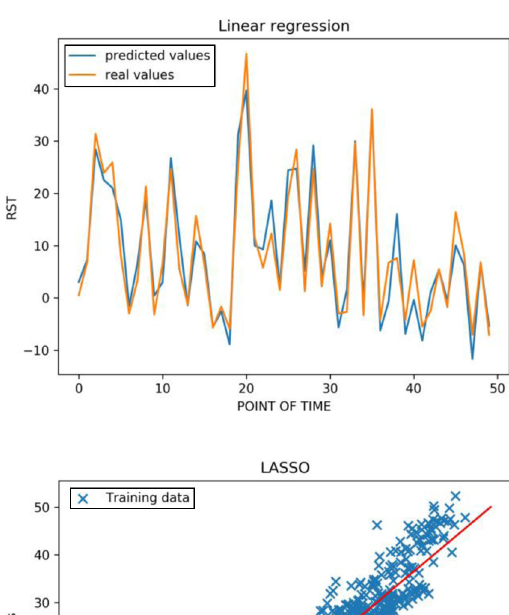
Figure 5. Regression plot for data samples with MLR